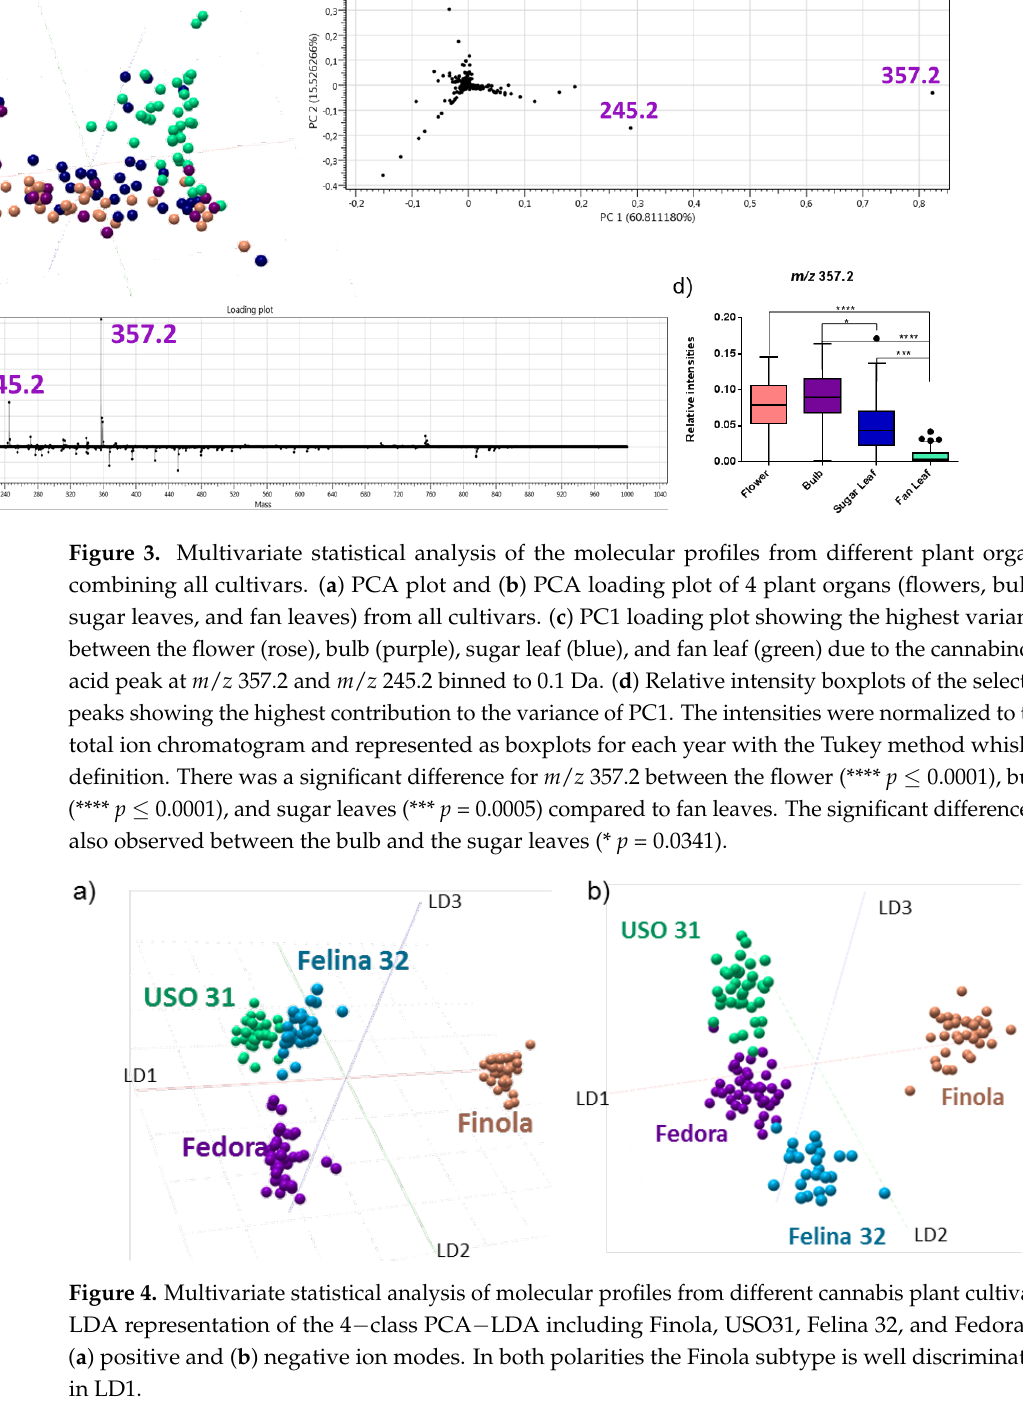
Figure 4. Multivariate statistical analysis of molecular profiles from different cannabis plant cultivars. LDA representation of the 4 − class PCA − LDA including Finola, USO31, Felina 32, and Fedora in ( a ) positive and ( b ) negative ion modes. In both polarities the Finola subtype is well discriminated in